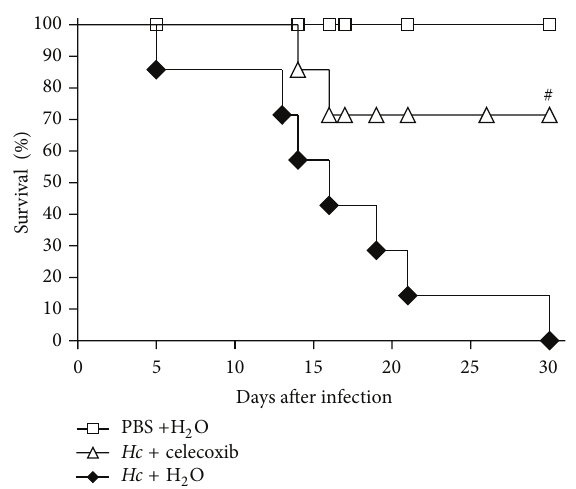
Figure 7: Celecoxib treatment increases the survival of mice infected with lethal inoculum of H. capsulatum . Mice infected with a lethal inoculum of H. capsulatum (1 × 10 6 yeast) were treated daily p.o. with water or celecoxib (1mg/kg/0.5 mL) for 30 days (𝑛 = 7) . A group of noninfected mice were used as controls (𝑛 = 5) . # Hc + H 2 O versus Hc + celecoxib. 𝑃 < 0.05 , using logrank